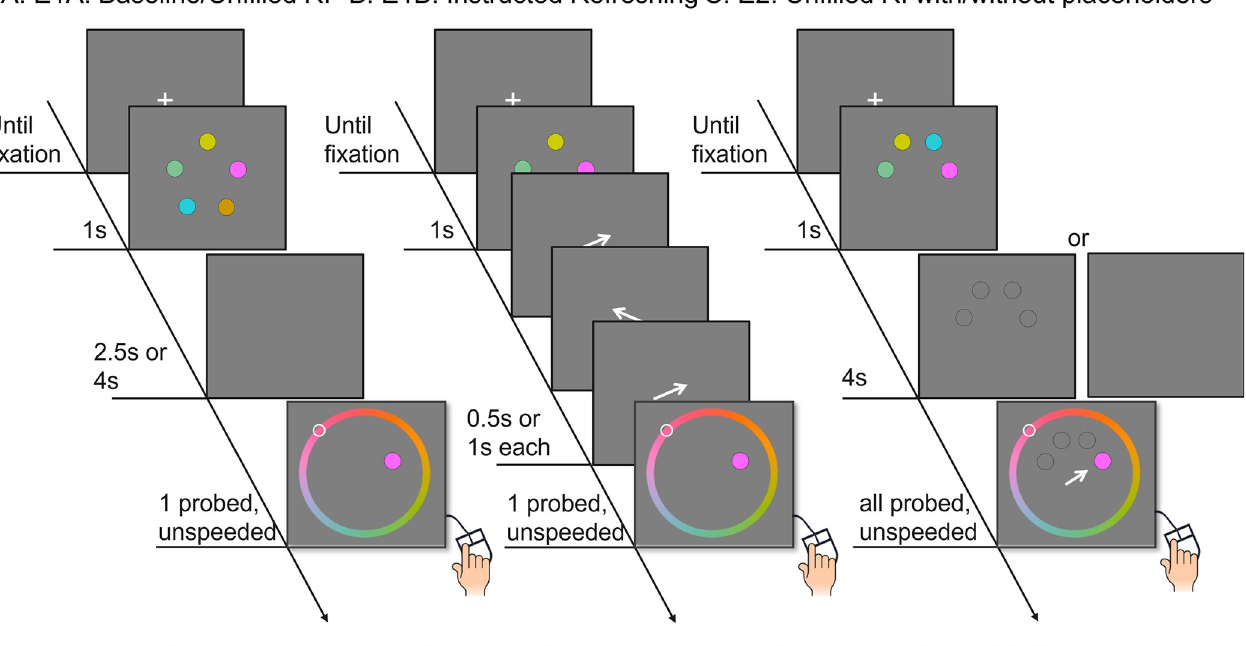
Fig 1. Example of the Task in Experiments 1A (Panel A), 1B (Panel B), and 2 (Panel C).